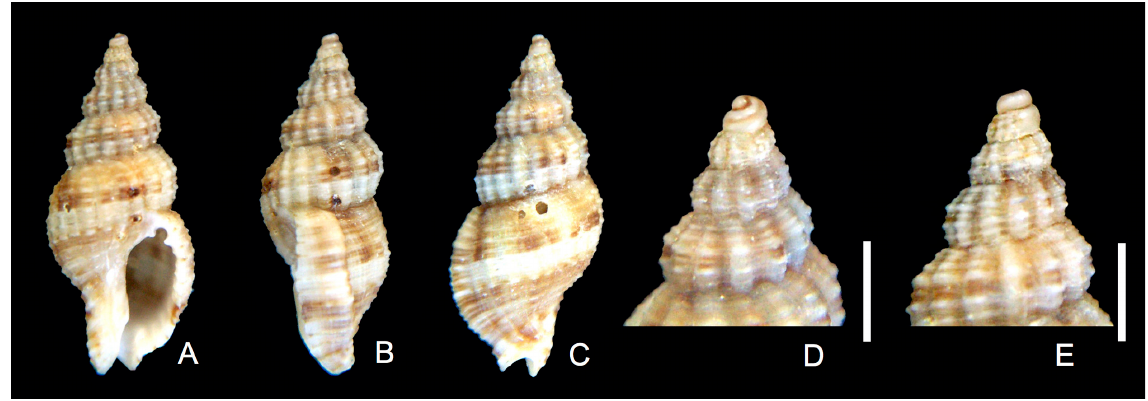
Fig. 6A–E. Sinetectula naevosa (Martens, 1880) gen. et comb. nov., off Mozambique, 15.0 mm long (KF 5029). Scale bars: 2.0